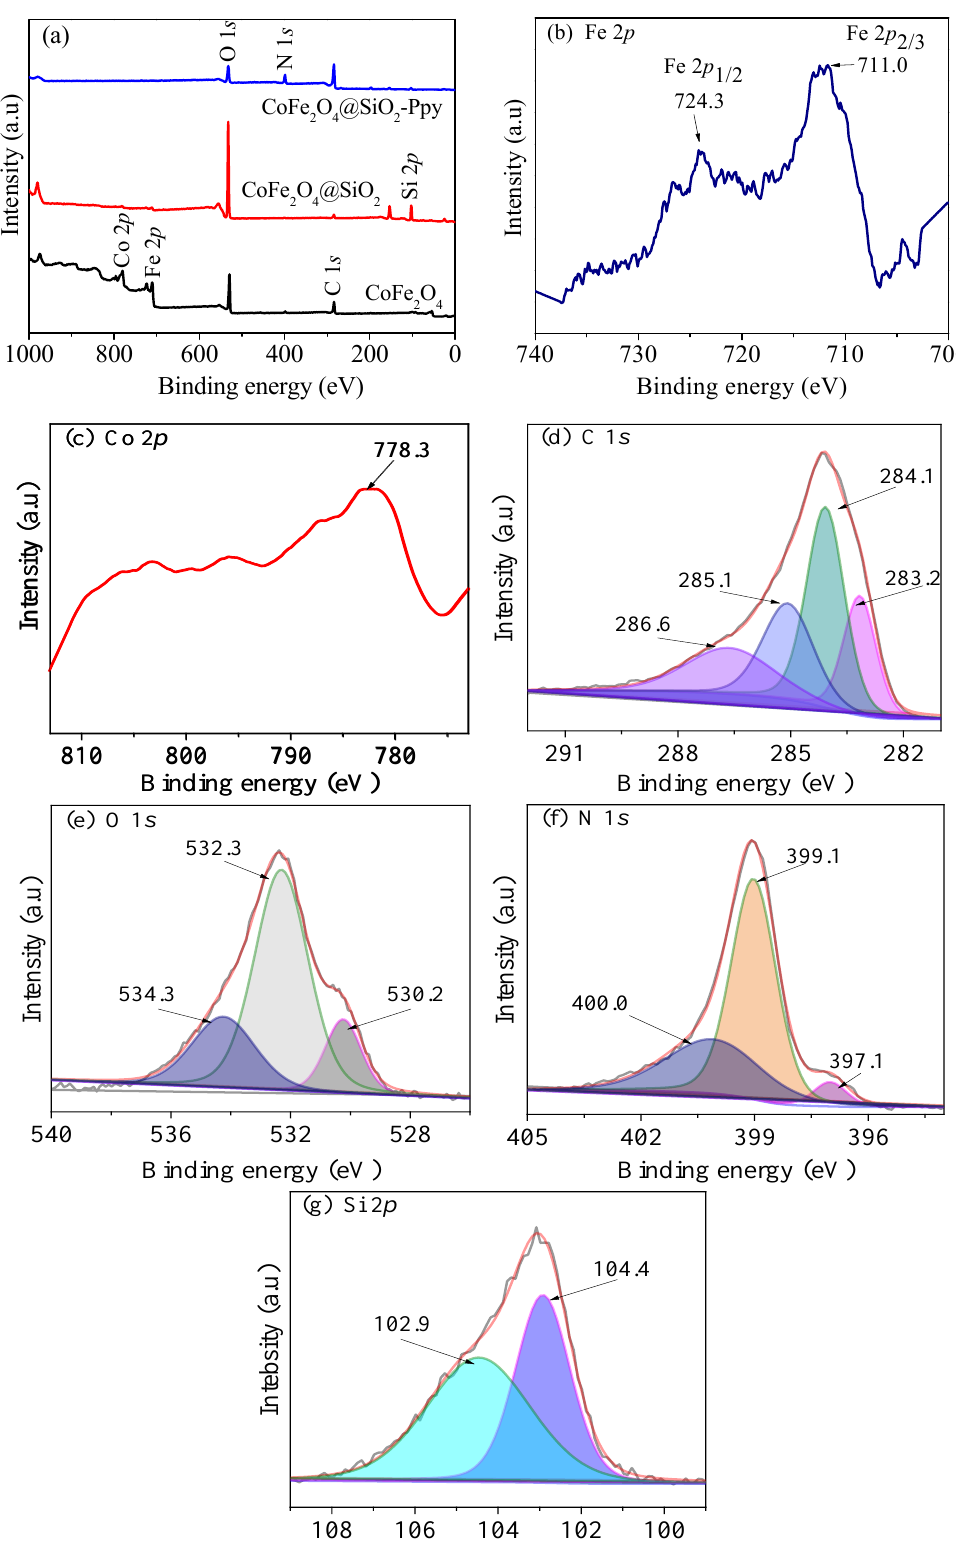
Figure 8. X-ray photoelectron spectroscopy (XPS) spectra of ( a ) survey scan; ( b ) Fe 2 p , ( c ) Co 2 p , ( d ) C 1 s , ( e ) O 1 s , ( f ) N 1 s , and ( g ) Si 2 p of CoFe 2 O 4 @SiO 2 -Ppy.